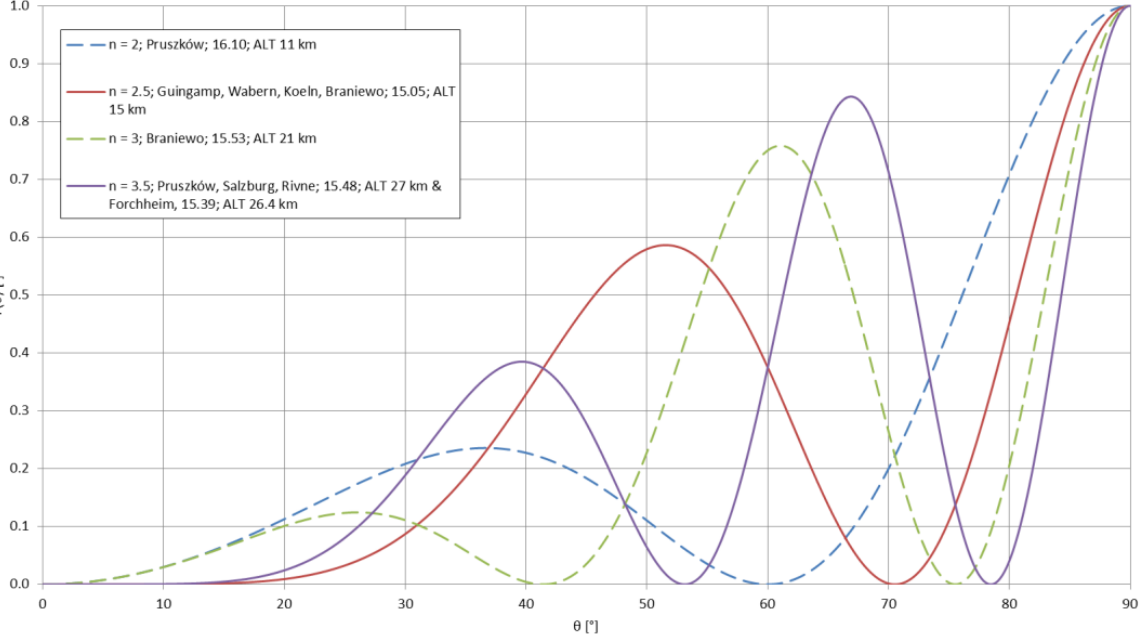
Figure 12. The antenna’s power pattern evolution for the indicated locations of the signal’s reception. The dashed lines represent the hypothetical patterns of the mission during the descent (as the antenna was coiled due to the loss of its tail weight during the launch, the actual pattern was expected to differ from a typical monopole).